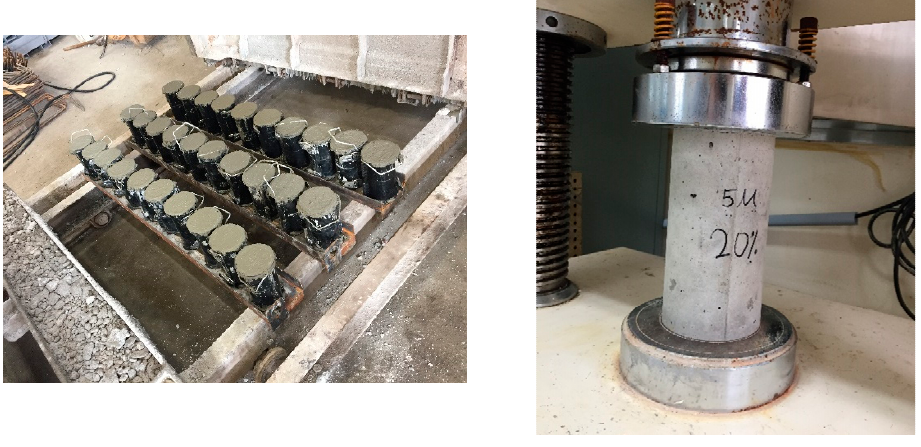
Figure 1. Test to measure the compressive strength.